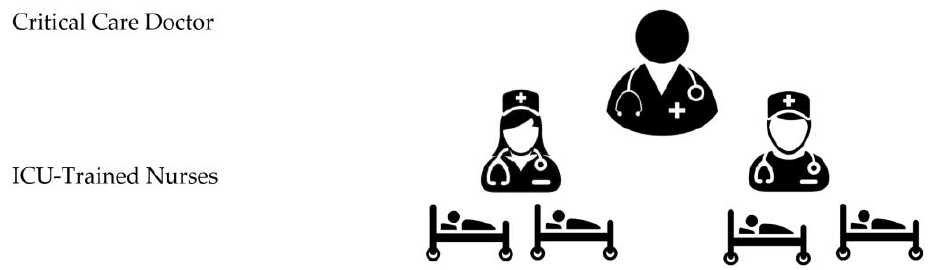
Figure 3. Standard ICU staffing model. (1 ICU-trained nurse: 2 patients). Rationale